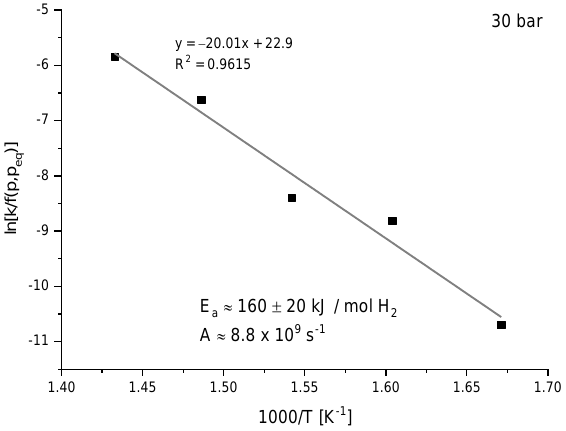
Figure 5. Plot of the data for calculating the activation energy value for absorption at 30 bar, according to the modified Arrhenius equation, extended with the driving force term.